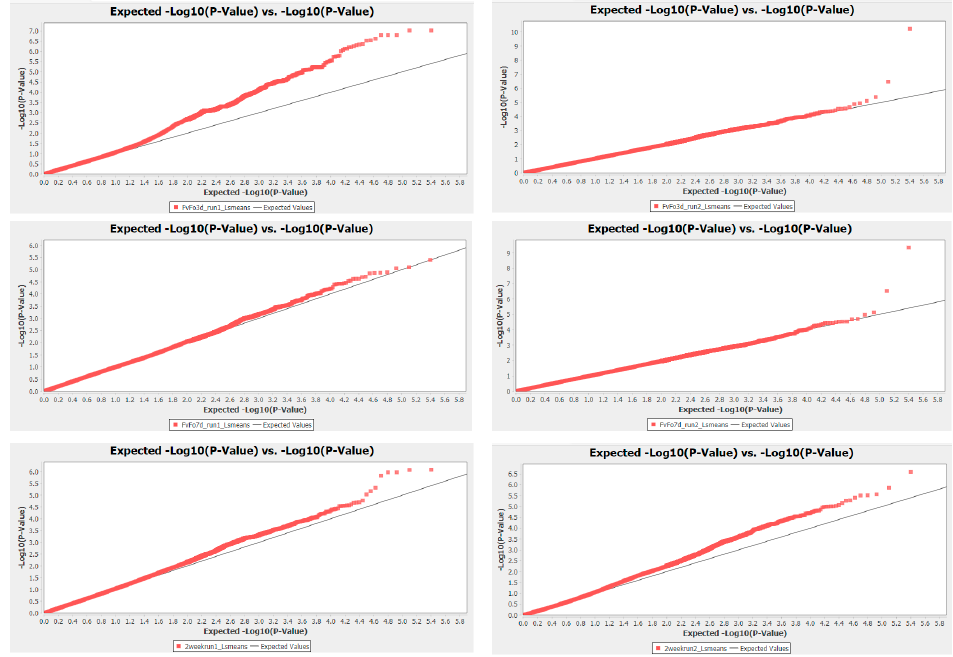
Figure 5. Q-Q plot showing the distribution of the observed and expected − log10 p -values. The X -axis is the expected p -values, and the Y -axis is the observed p -values. The black line represents the expected p -values with no association existed, and the red line/dots represent observed p -values. Table 2. Mean Squared Distance (MSD) analysis to assess the fit of the various models for each of the experimental runs for the three phenotypic analyses. The table is ordered based on the average MSD for all six analyses. Highlighted values indicate the best model for each analysis.